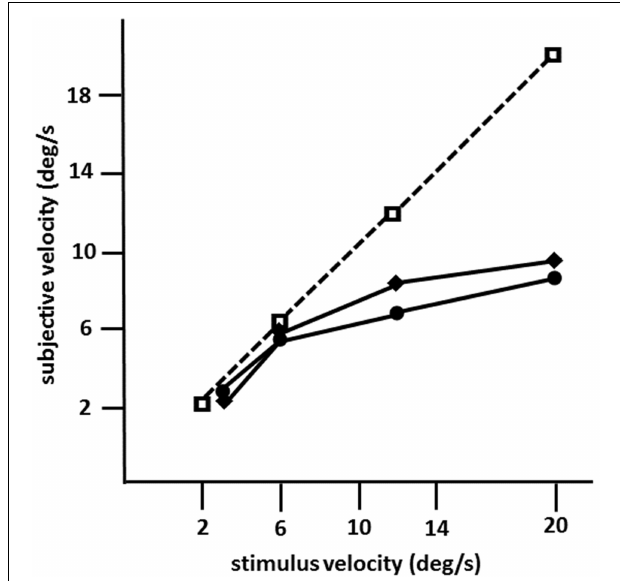
FIGURE 4 | Mean subjective velocities for LM in 1982 (circles) and in 1990 (diamonds), and in an age-matched normal subject (squares; same as in Figures 1B, 2A; 10 trials per velocity) as a function of stimulus velocity calculated from motion prediction responses (modified after Zihl et al., 1983, 1991). LM was instructed to press a key to start the target in motion, and to press it again when she judged that the now invisible target had reached a red marker behind a mask. The path of horizontal movement was 10 ◦ ; the length of the path behind a mask was 20 ◦ . Note that motion prediction accuracy in LM dropped for stimulus velocities > 6 ◦ /s on both